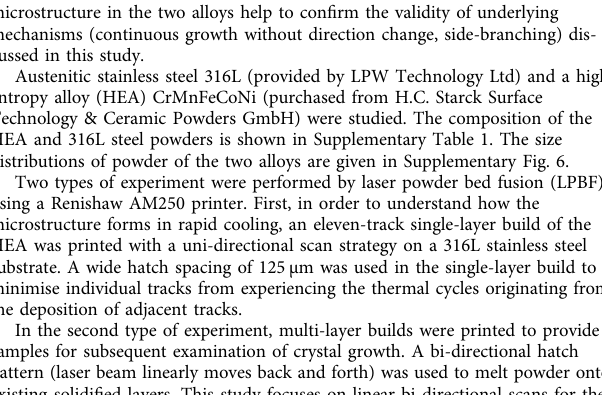
Fig. 7 Crystallographic orientations and plastic anisotropy associated with three different scan strategies. Pole fi gures of HEA samples fabricated by a strategy 1: bi-directional scanning without rotation, b strategy 2: chessboard with 67° rotation, and c strategy 3: bi-directional scanning with 90° rotation (Note: X is parallel to TD1, Y is parallel to TD2 and BD is at the centre of the pole fi gures). d Hardness measurements when loading direction being parallel and perpendicular to BD. (The upper and lower limits of the error bars represent the 25th and 75th percentile of the measurements,